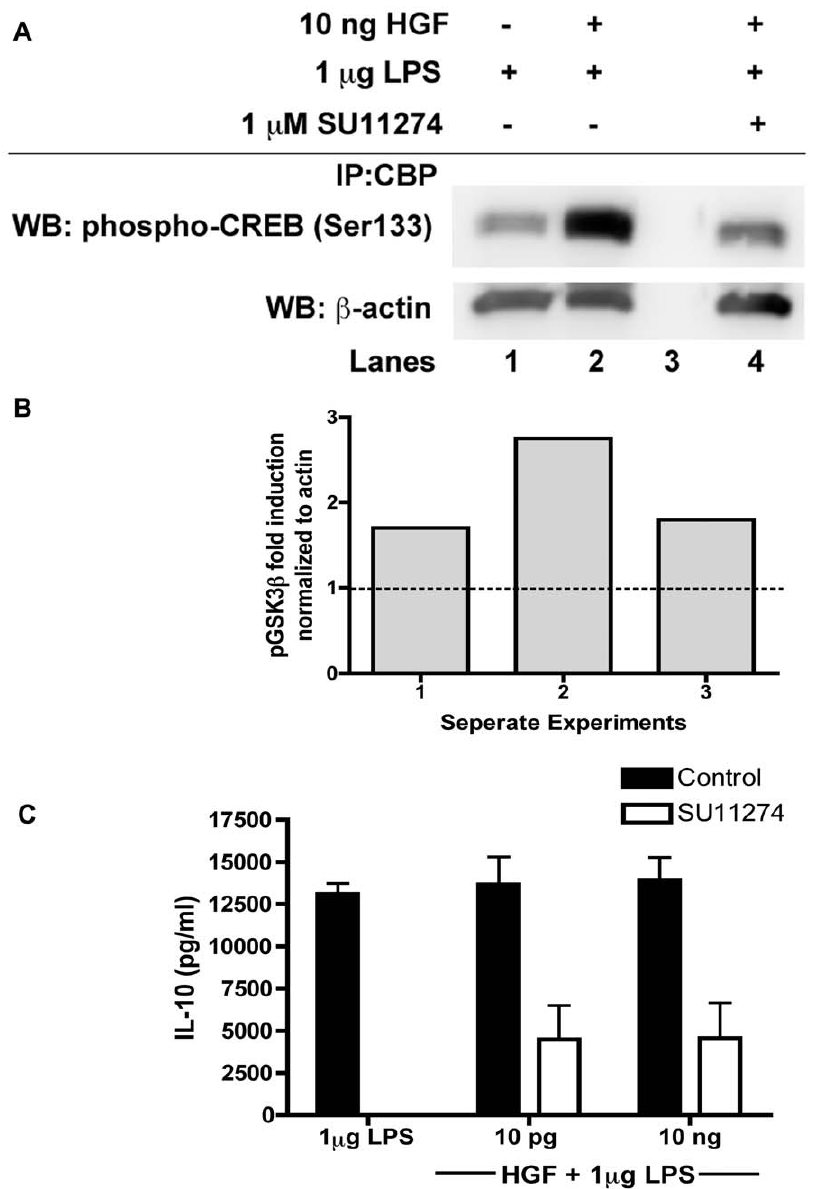
Figure 5. HGF promotes the interaction of phosphorylated CREB with CBP along with an increased production of IL-10. (A) Whole cell lysates prepared from BMM were incubated overnight with HGF (10 ng) prior to stimulation LPS (1 m g/ml) for 15 minutes, then subjected to immunoprecipitation with a CBP antibody. The lysates were separated by SDS-PAGE and probed with a phospho-specific CREB antibody before re- probing for b -actin. (B) Densitometric analysis for phospho-CREB fold induction normalized to b -actin. Is shown for 3 separate experiments. Note that all experiments show induction greater than 1 when HGF is present. (C) BMM were pretreated with or without 1 m M of the MET kinase inhibitor (SU11274) for 2 h prior to incubation with HGF (1, 10 and 100 pg) for 24 hours followed by stimulation with 1 m g/ml LPS. Cell culture media was collected (24 h) and IL-10 levels were measured by ELISA. Results are representative of two independent experiments done in triplicate.